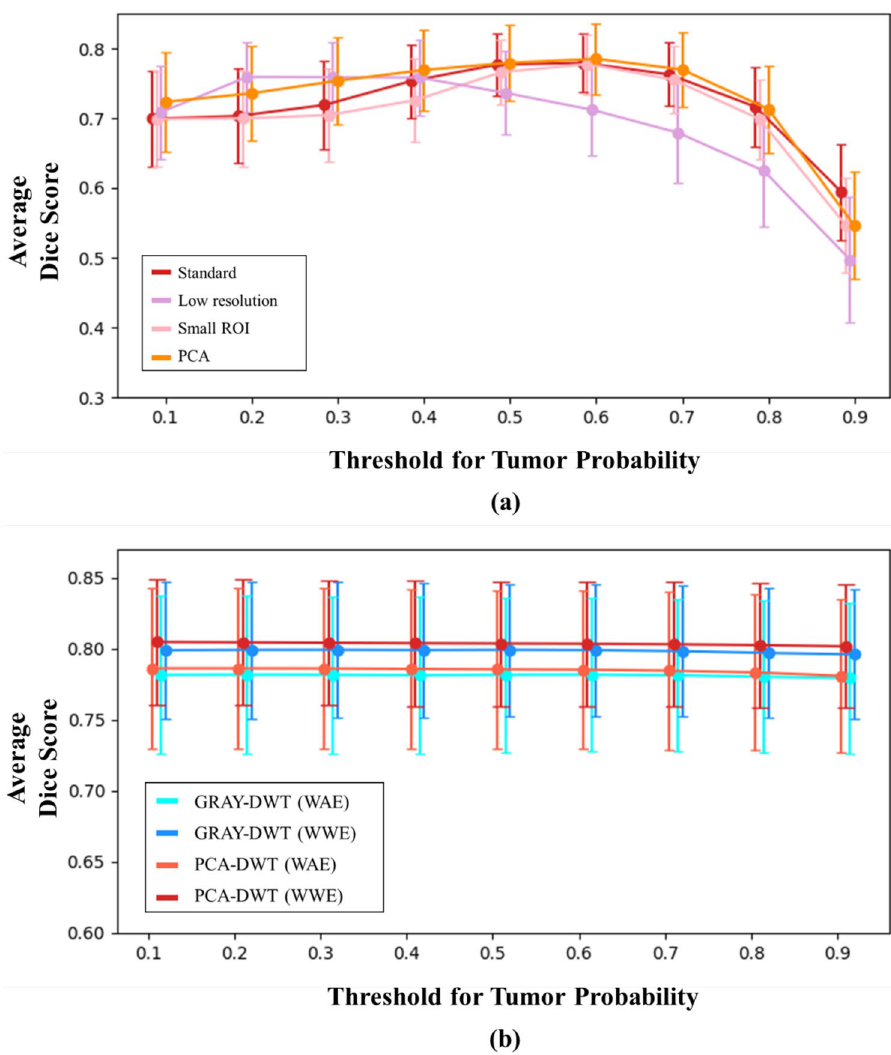
Figure 4. Comparative Dice of wavelet weighted ensemble (WWE) for wavelet sub-bands, weighted average ensemble (WAE) for wavelet sub-bands, and the result in spatial domain according to the threshold for tumor probability (95% confidence